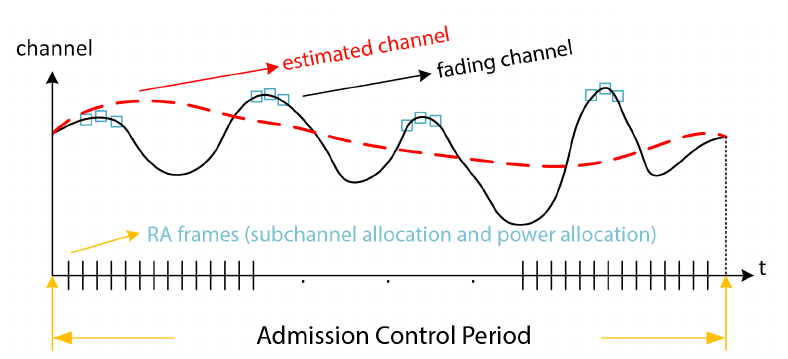
Figure 2. Time scale of admission control and resource allocation with respect to channel